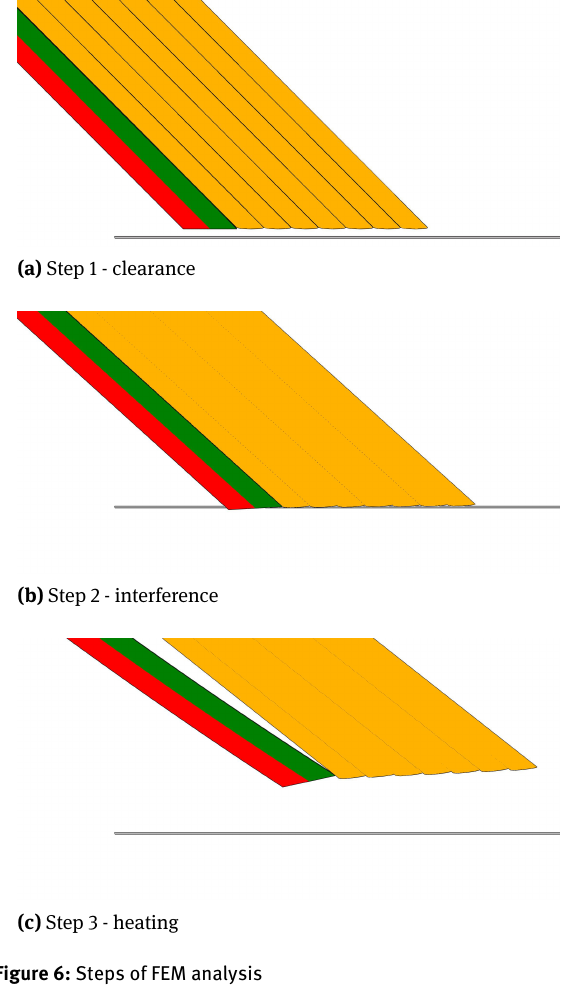
Results are shown in Figure 7.